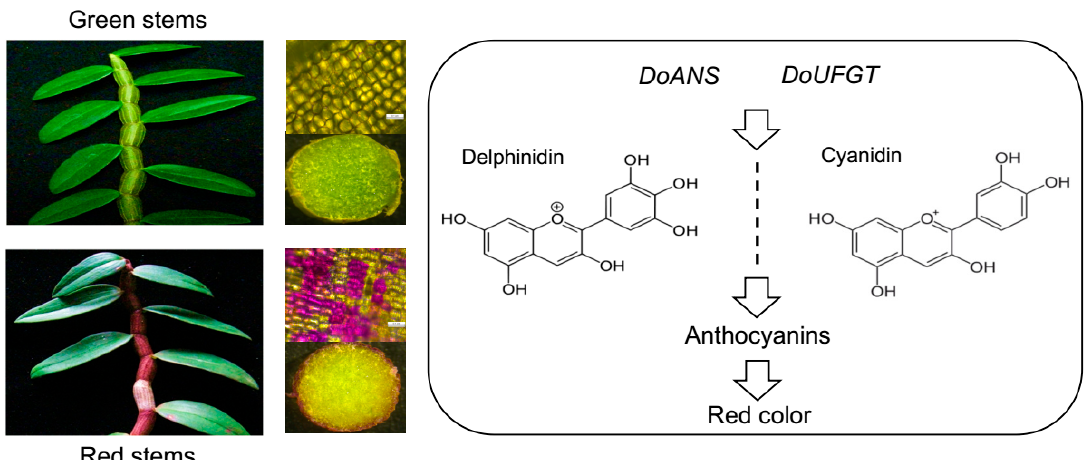
Figure 5. A summary of the differential anthocyanin accumulation in red and green D. officinale stems. D. officinale stems have green or red peels, and red stems are caused by the accumulation of anthocyanins. The red color is dominated by anthocyanin derivatives, delphinidin and cyanidin, which mainly exist in anthocyanin-containing epidermal cells. In addition, DoANS and DoUFGT are vital regulatory genes in anthocyanidin accumulation; DoANS , the gene coding anthocyanidin synthase from D. officinale ; DoUFGT , the gene encoding UDP-glucose flavonoid 3- O -glucosyltransferase from Dendrobium officinale .